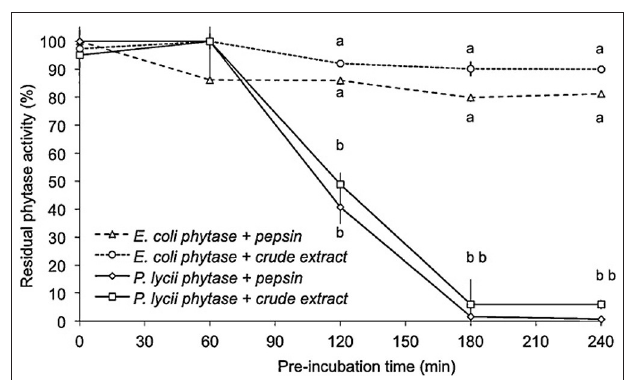
FIGURE 5 | Residual phytase activity of E. coli and P. lycii phytase after pepsin or gastric crude extract from trout stomach hydrolysis throughout incubation time (0, 60, 120, 180, and 240 min). The incubation was performed by adding 1 FTU phytase to a protease solution with 5000 U from porcine pepsin or gastric crude extract from fish, performed at pH 2.0 (HCl), 16 ◦ C. The results are plotted as the mean ± SE (triplicates). Different letters, for each time, indicate significant differences (P<0.05) between phytases